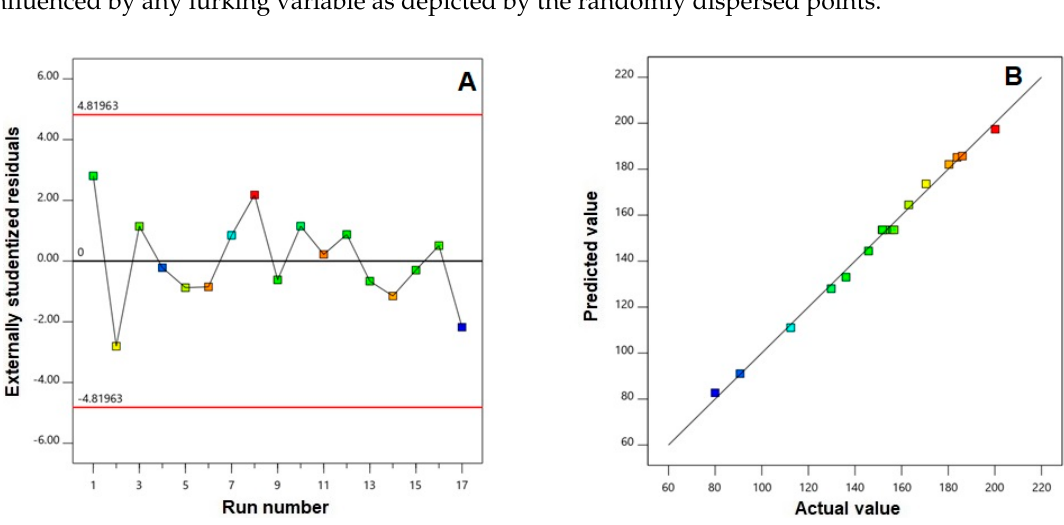
Figure 1. ( A ) Externally studentized residuals vs. run number plot and ( B ) Predicted vs. actual values plot for particle size of FBX-EMLs.